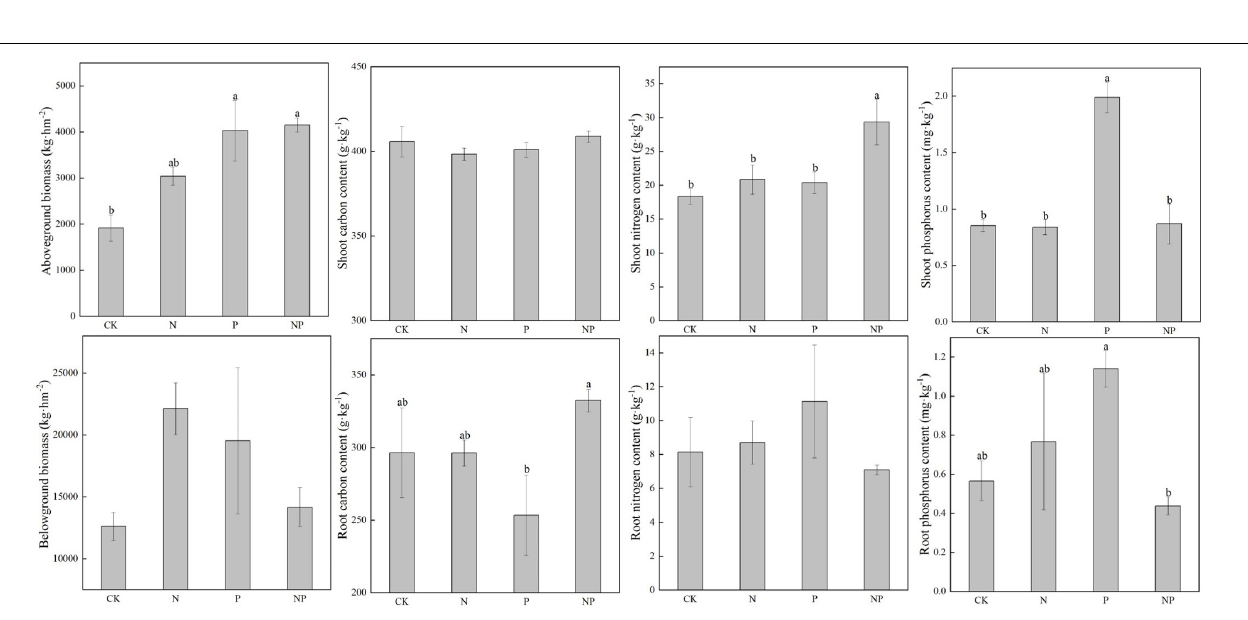
FIGURE 7 | Plant biomass and nutrients under different experimental treatments. Different letters indicate significant differences at a p < 0.05 level across experimental treatments. No letter indicates a non-significant difference (CK = control, N = addition of 72 kg N hm − 2 year − 1 , P = addition of 36 kg P hm − 2 year − 1 , NP = interaction of N and